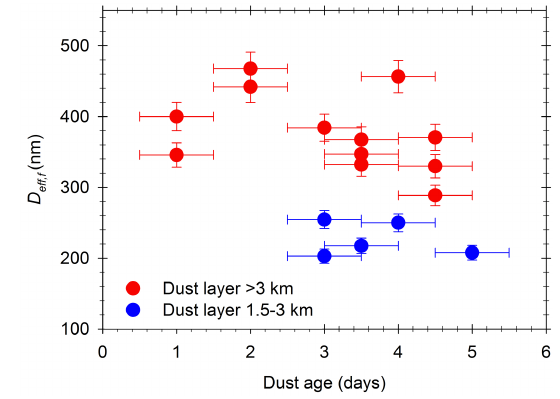
Figure 10. Effective diameter of the fine mode D eff,f as a function of the dust age observed for the above-3km dust layers (red circles) and the below-3km dust layers (blue Figure 9. Altitude dependence of (a) the fine mode effective diame- ter D eff,f (size range 0.053–1µm) and (b) the coarse mode effective diameter D eff,c (size range 1–20µm). The altitude reported for ver- tical profiles refers to the middle of the layer. Broad classifications of the above-3 km dust layer, the below-3km dust layer and the boundary layer have been added to the figure. Table 4. Aerosol optical parameters (real part of the complex re- fractive index n r , imaginary part of the complex refractive index n i , single scattering albedo ω 0 , asymmetry parameter g and mass extinction efficiency k ext ) all at λ = 530nm as a function of the altitude. The mean, minimum and maximum of all parameters are listed. n r n i ω 0 g k ext